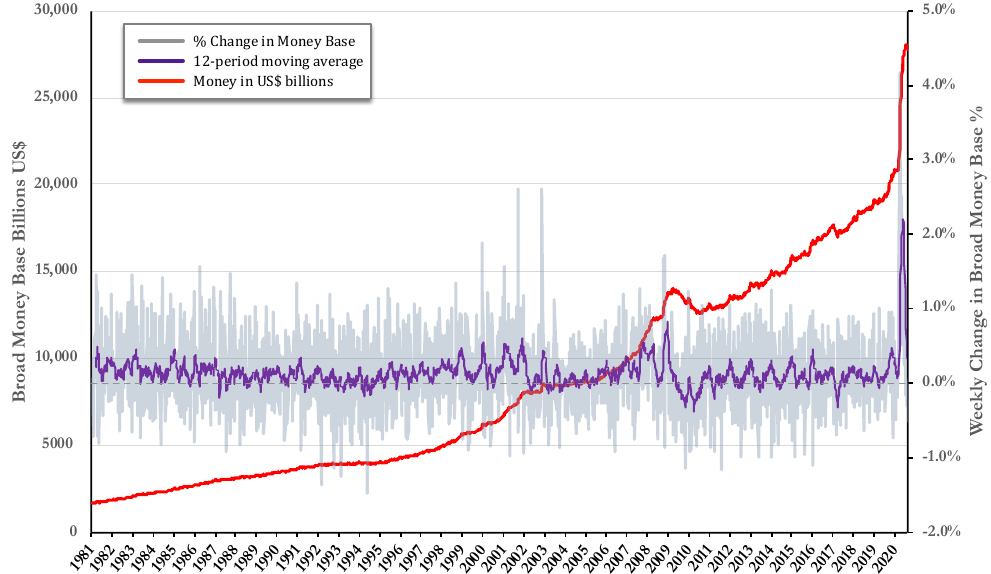
Figure 3. Growth in the United States’ monetary base (M2 + MZM + Government